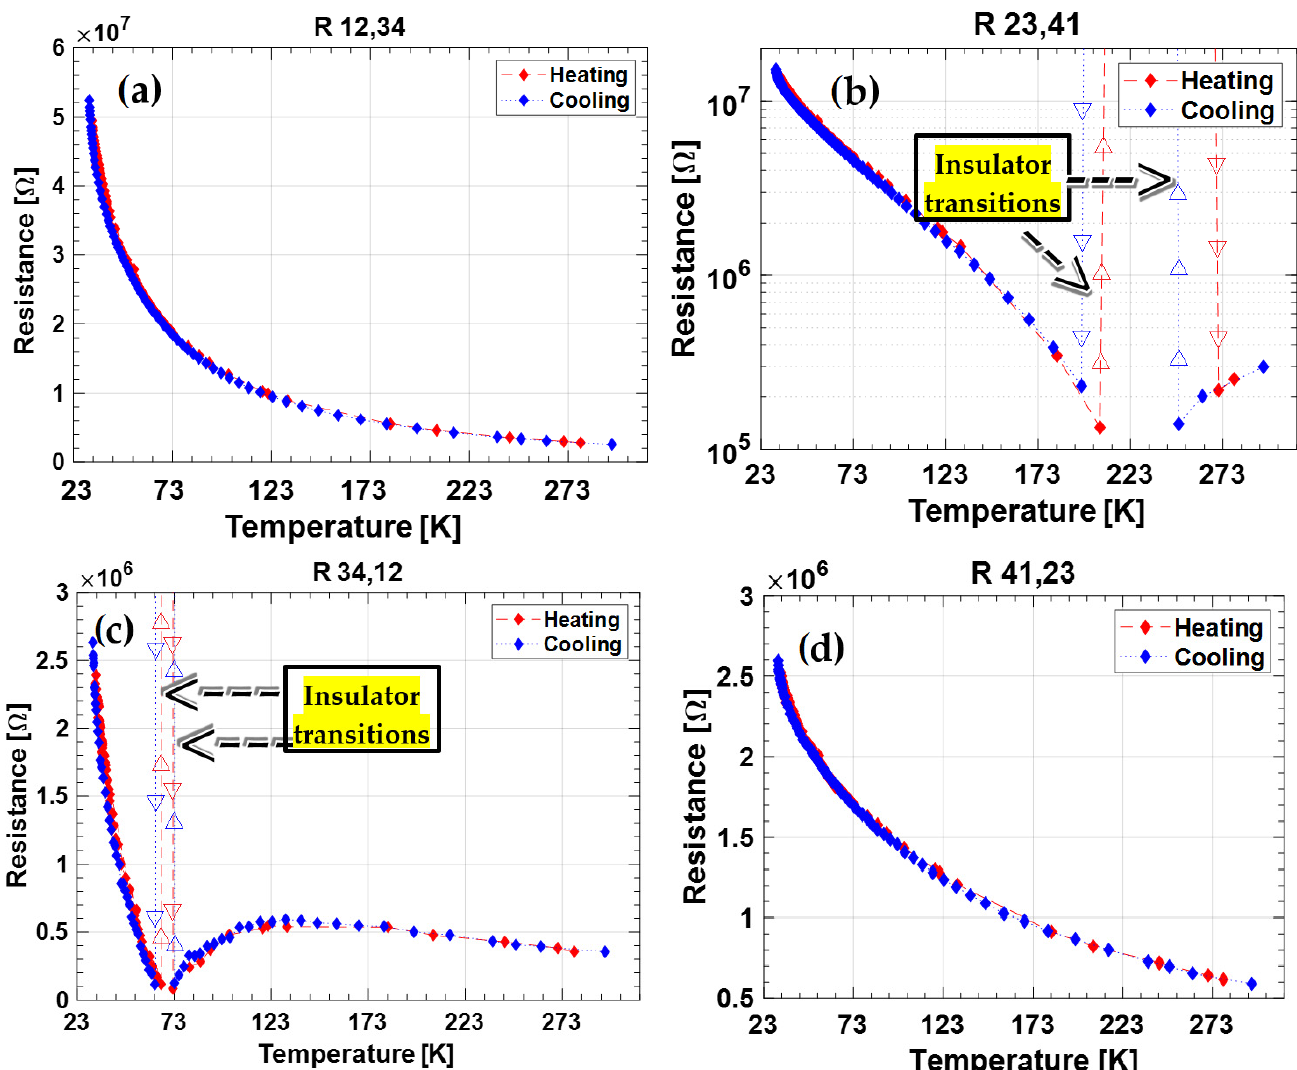
Figure 4. Measured resistance of sample 2T-9010 during the characterization performed following the Van der Pauw method. ( a ) Current injected at contacts 1–2; ( b ) current injected at contacts 2–3; ( c ) current injected at contacts 3–4; ( d ) current injected at contacts 4–1. The figure relative to the second cycle of both samples is represented on logarithmic y-axes in order to have eye-evidence over the NTC → PTC transition.